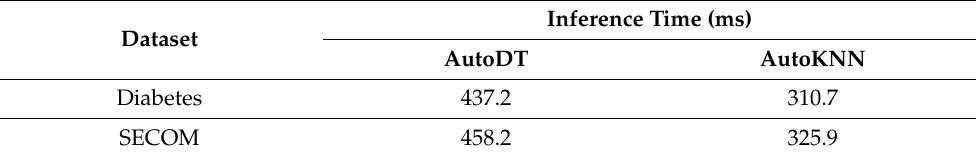
Table 10. Inference time for the first sample after each UPDATE_THR .